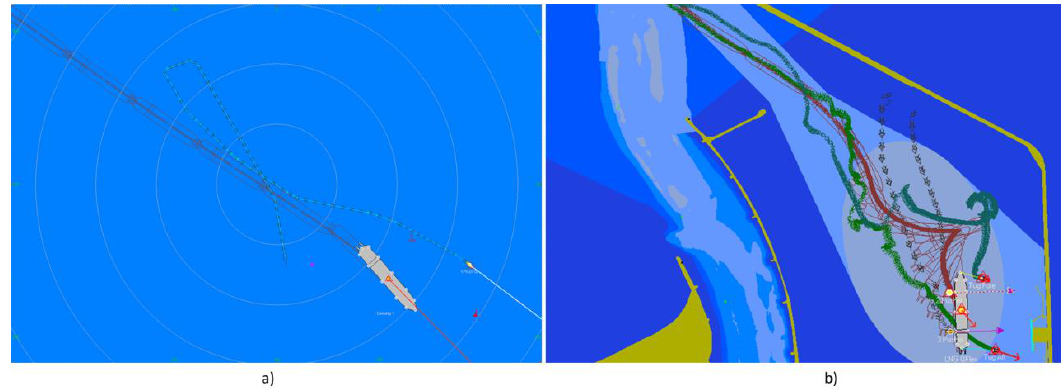
Figure 2. The test areas of the simulation experiment: ( a ) open sea area; ( b ) restricted area.